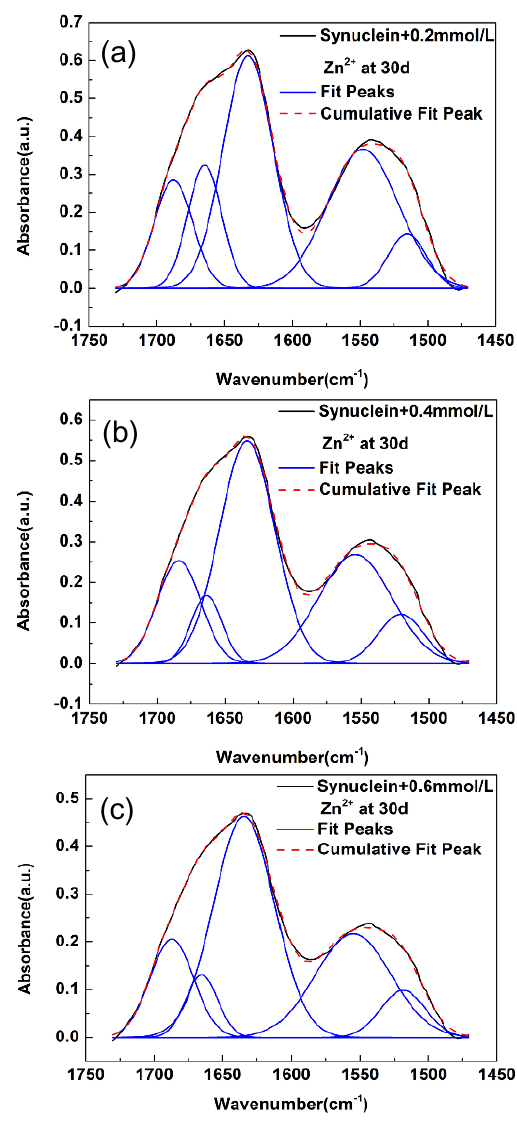
Figure 2. FTIR spectra of α -synuclein amyloid fibril under the influences of different concentrations of Zn 2+ and curve-fitting results in the amide I region. ( a ) 0.2 mM; ( b ) 0.4 mM; ( c ) 0.6 mM; solid black line: measured spectrum; dash red line: overall fit; solid blue line: fitted subpeak. a.u.: arbitrary unit. Table 2. Curve-fitting results of the FTIR spectra of α -synuclein amyloid fibril under the influence of different concentrations of Zn 2+